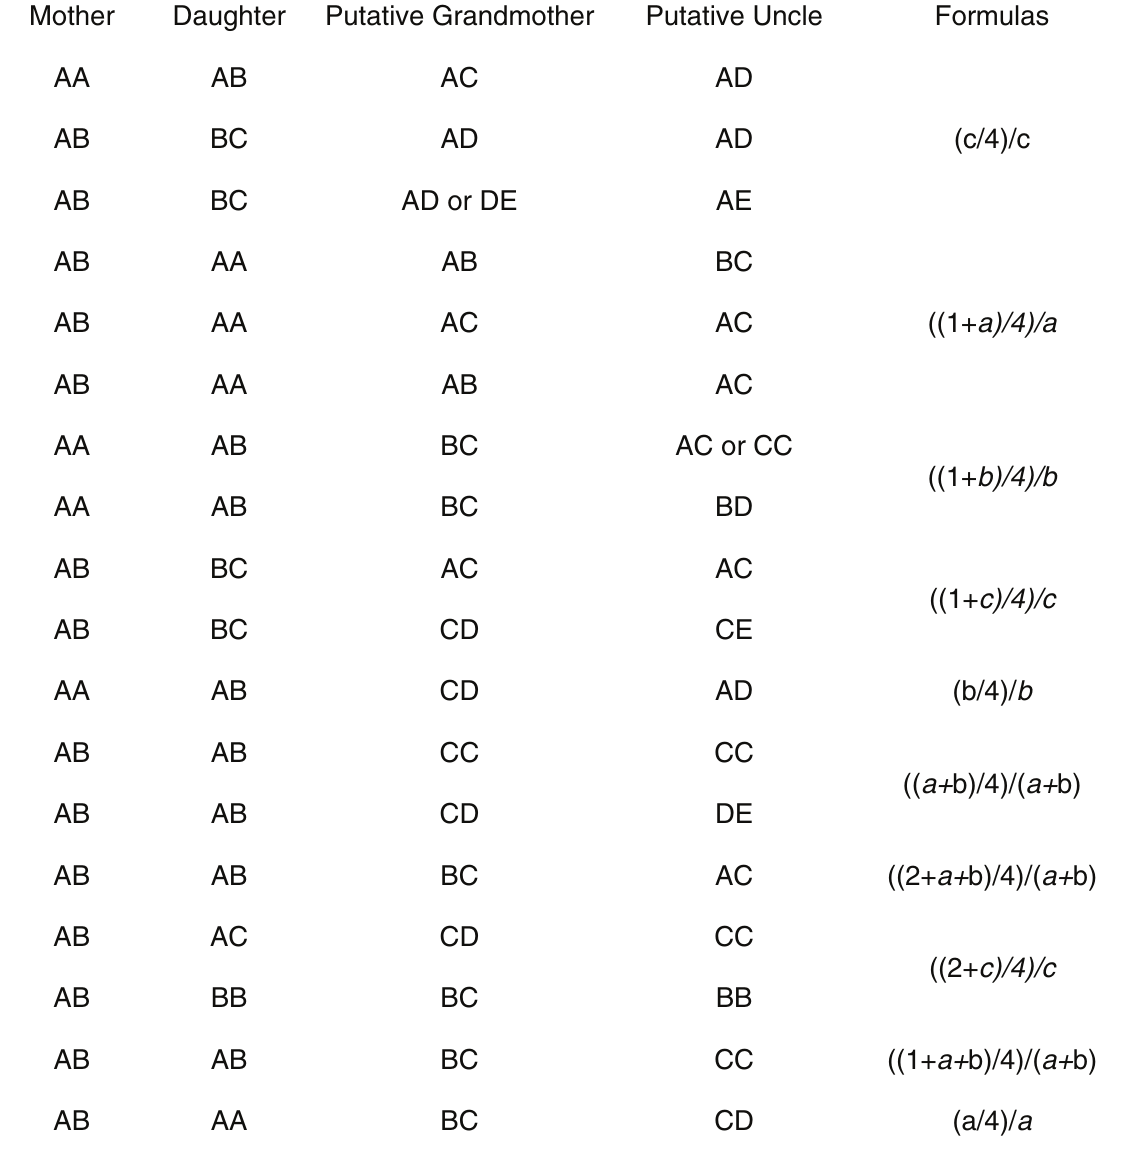
Table S2 - Formulas to calculate PI considering the profile configurations depicted with AS STRs, in case 1.